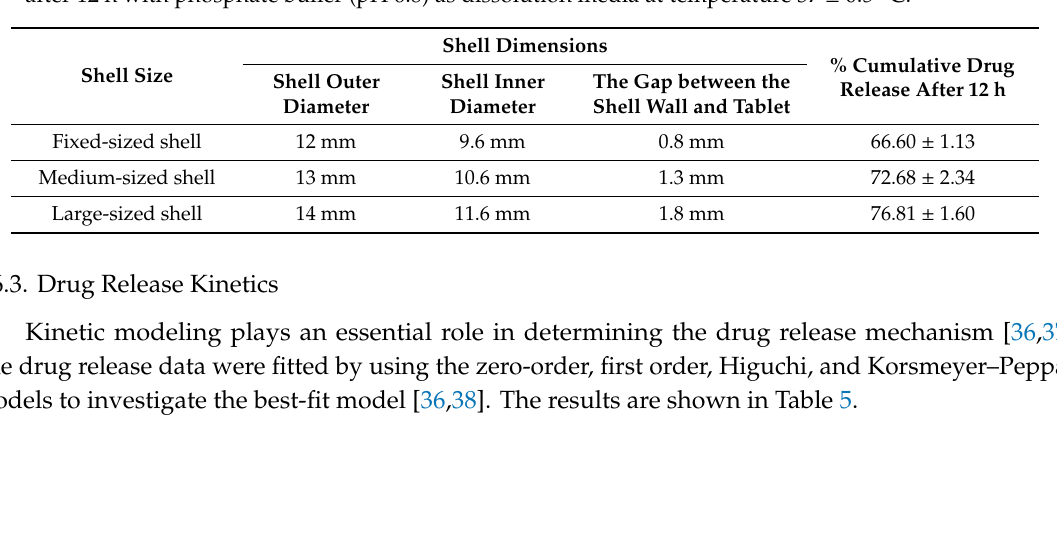
Figure 4. ( a ) Cumulative release of propranolol HCl from the model tablet with phosphate bu ff er (pH 6.8) as dissolution media at temperature 37 ± 0.5 ◦ C versus when enclosed inside 3D printed coating shells with di ff erent excipient ratios (Table 3). ( b ) The coating shell system still intact after the dissolution experiment. The cross-section of the shell shows the expansion of the propranolol HCl